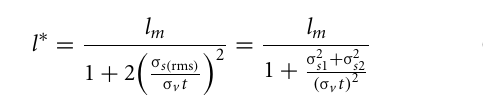
FIGURE 7 | Bayesian perception is optimal because it is biased . On each of 1 million trials, a first tap position ( x 1 ) was drawn from a uniform distribution, and a second tap position ( x 2 ) was drawn from a Gaussian distribution centered on the first tap position, with standard deviation t σ v = 1.5cm (i.e., σ v = 10cm/s, t = 0.15s; see Eq. A8 in Appendix). Measured positions, x 1 m and x 2 m , were then drawn independently from Gaussian distributions of standard deviation σ s = 1cm, centered on the corresponding tap positions ( x 1 and x 2 ). (A) Left : scatterplot of measured trajectory length ( l m = x 2 m − x 1 m ) against actual trajectory length ( l = x 2 − x 1 ) for each of the trials (dots); negative lengths indicate trajectories in which x 2 < x 1 . Dashed vertical and horizontal lines: l = 0 and l m = 0. Diagonal dashed line: l m = l . Vertical blue line: l = 3cm. Horizontal red line: l m = 3cm. Center : histogram (h) of l m values that occurred when l was between 2.95 and 3.05cm (i.e., l m